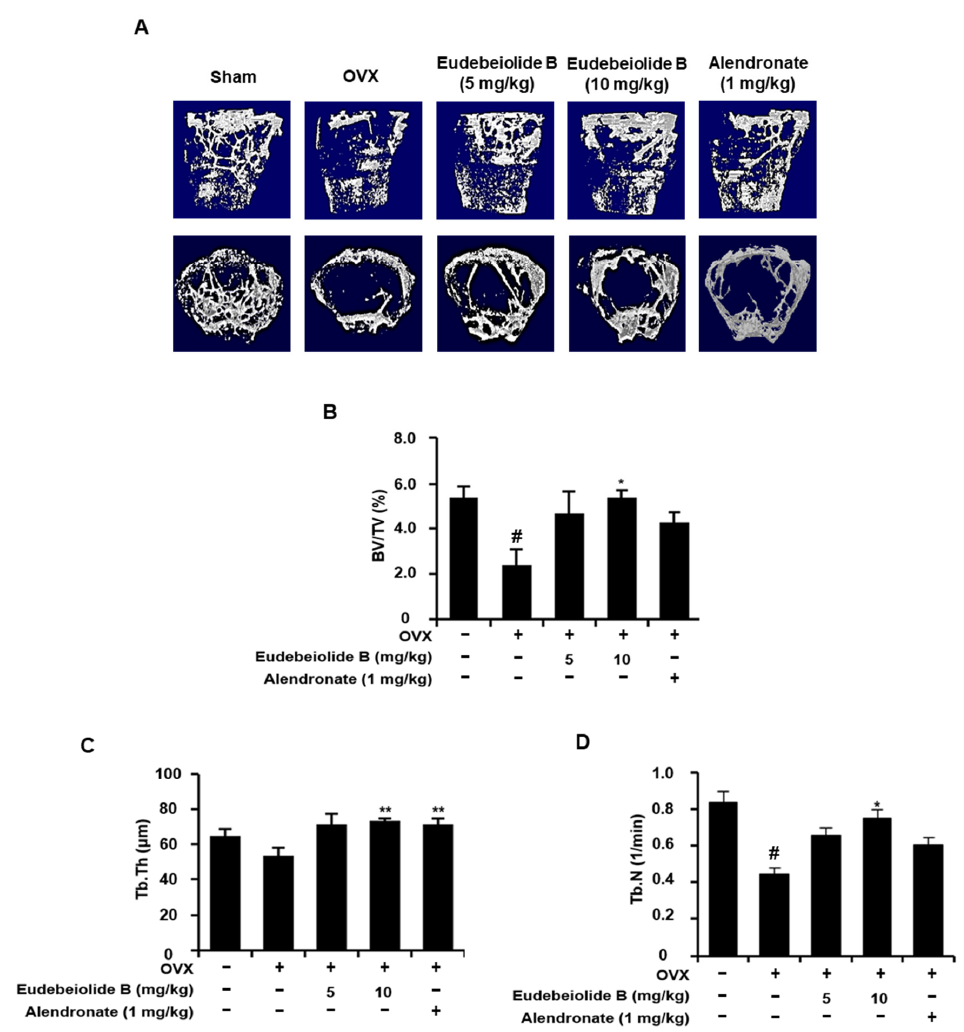
Figure 6. Micro-CT analysis of the proximal femurs from the eudebeiolide B- or alendronate-treated OVX mice. ( A ) The micro-CT images of longitudinal and transverse of the proximal femurs from the sham-operated, OVX + vehicle, OVX + eudebeiolide B-treated and OVX + alendronate-treated mice were obtained. ( B ) The bone volume/total volume (BV/TV), ( C ) trabecular thickness (Tb. Th.) and ( D ) trabecular number (Tb. N.) of the femurs were analyzed using micro-CT ( n = 6). Data are expressed as the means ± S.D. # p < 0.05 versus the sham group obtained through the unpaired Student’s t -test; * p < 0.05, ** p < 0.01 versus the only-OVX-treated group obtained through one-way ANOVA followed by Dunnett’s test.